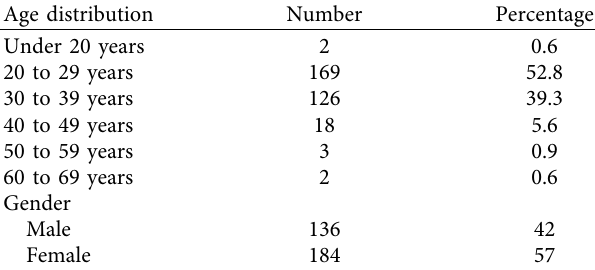
Table 1: Demographic